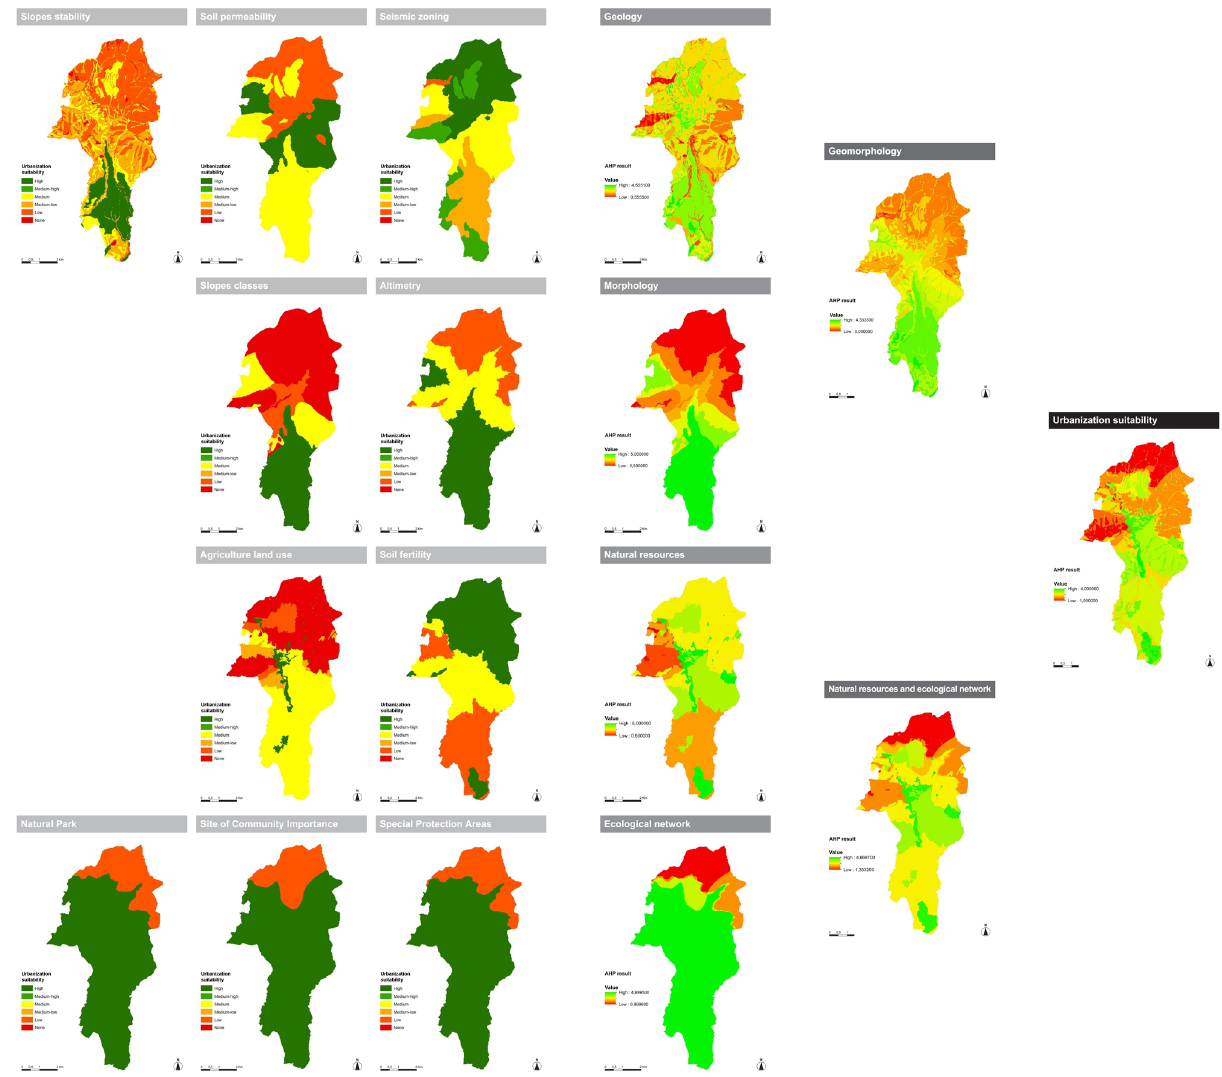
Fig. 2. Hierarchical structure of criteria for the urbanization